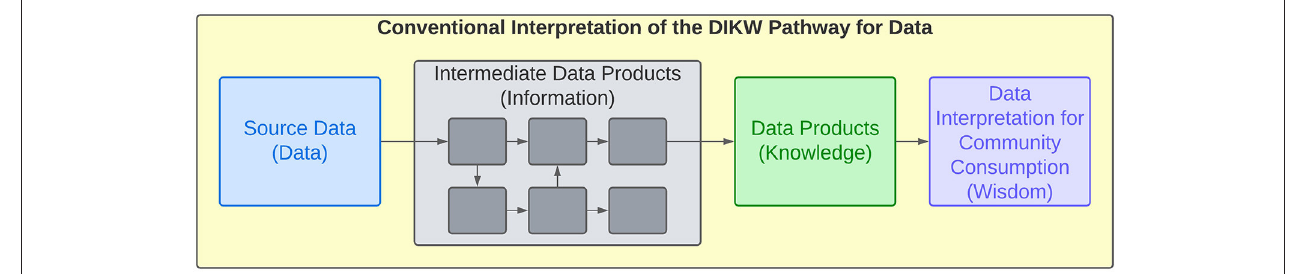
FIGURE 1 | The linear equivalent of the DIKW pathway for